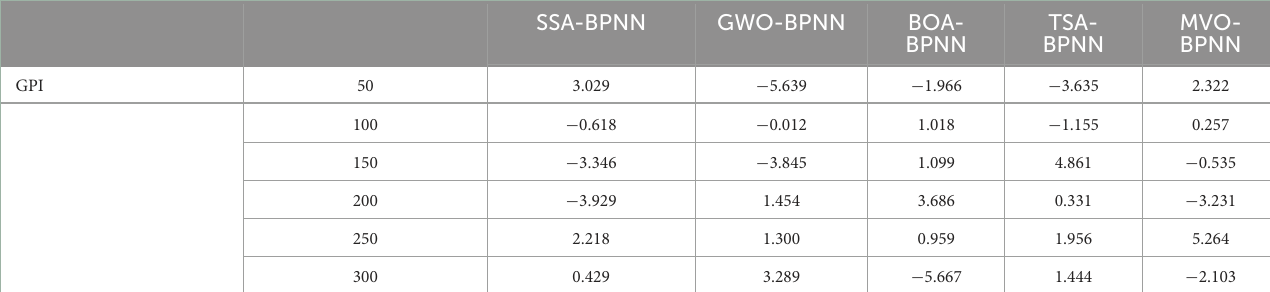
TABLE 2 GPI values for different population sizes of the hybrid